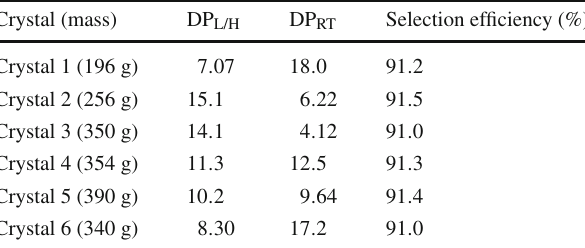
Table 2 DP values and the effective selection efficiency (See Sect. 5.1) by using both the L/H and RT cuts at the Q value of 100 Mo